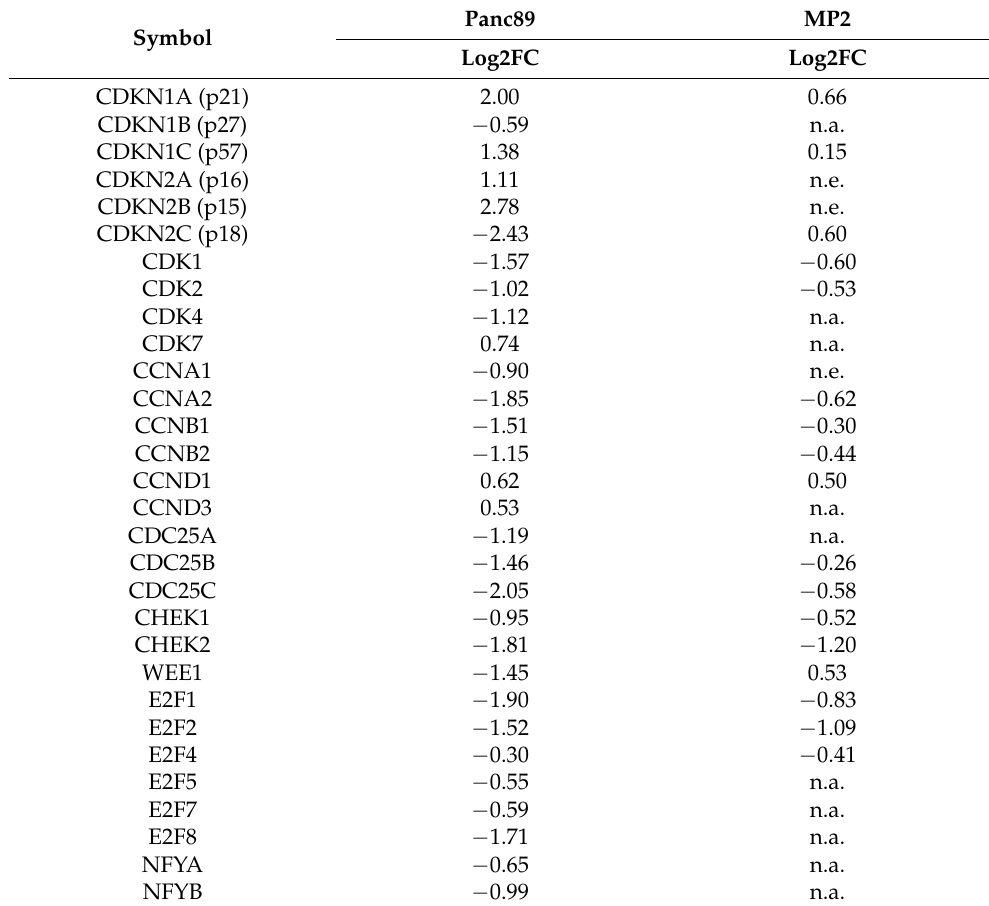
Table 1. RNAseq changes of selected genes connected to cell cycle control (n.a. not altered, n.e. not